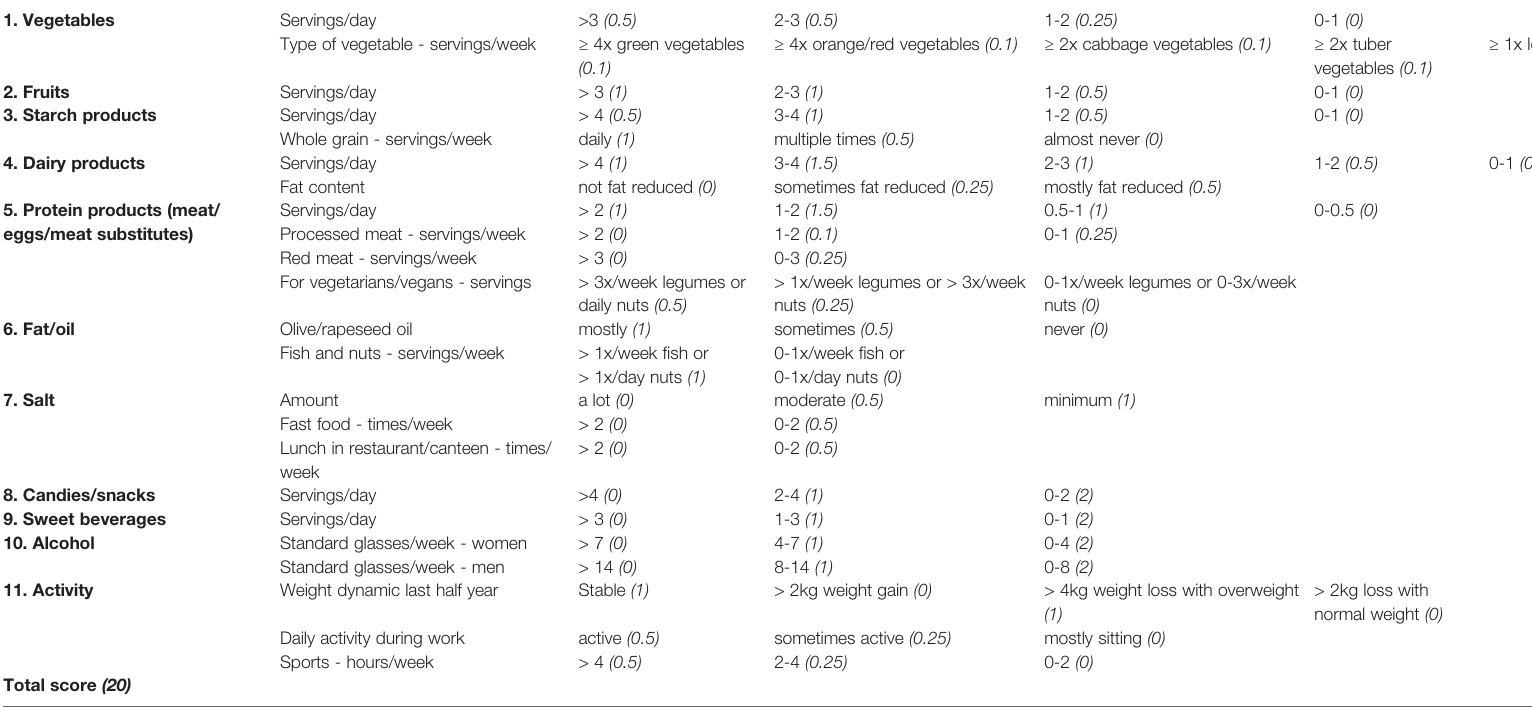
TABLE 2 | Nutritional score with subgroups of dietary